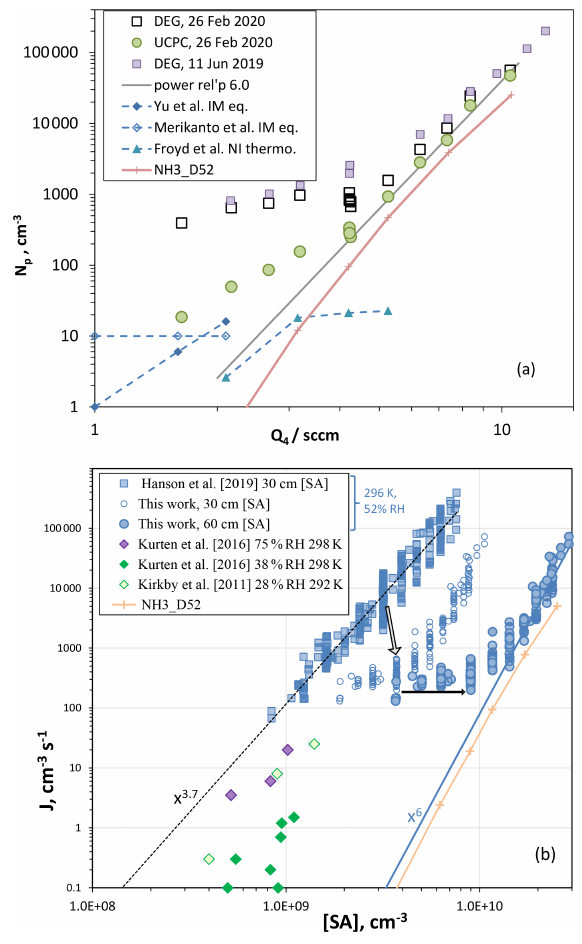
Figure 5. (a) N p vs. Q 4 , two different particle counting systems. DEG system refers to the nano-MPS followed by a diethylenegly- col CPC ( N p for the leading edge), and UCPC is a butanol-based detector. DEG system data from 2019 are also shown. N p is from ion-mediated (IM) nucleation from Yu et al. (2020) (BIMN, binary ion-mediated nucleation) and from Merikanto et al. (2016) (rates multiplied by 5s nucleation time). Also shown is N p calculated in our 2D model for negative ions (NI, thermodynamics from Froyd and Lovejoy, 2003, blue diamonds) and for neutral nucleation us- ing NH3_D52 thermodynamics (peach + ). A power dependency of Q 6 is also shown that describes the upper half of the UCPC data. 4 (b) Nucleation rate vs. H 2 SO 4 (SA) concentration. Nucleation rate given by total number of particles ≥ 2 . 3nm in the DEG distribution divided by an estimated 5s nucleation time. The [SA] concentration calculated at 30cm was used to plot both the Hanson et al. (2019) data set and this work (open circles). The filled circles are the nu- cleation rates for this work but plotted at the 60cm calculated [SA] concentration. The arrows indicate the system’s evolution for results at Q 4 = 4 . 25sccm. Nucleation rates from the CLOUD experiment at 292 and 298K for nominal binary conditions are also shown. The nucleation rate calculated using the 2D model with NH3_D52 ther- modynamics is also plotted ( + ) at 60cm